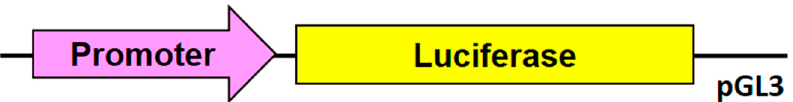
Figure 3. Scheme of the reporter constructs (based on pGL3). Promoter—FAP, CXCL12, IGFBP2, CTGF, JAG1, SNAI1, or SPARC, which are the promoters of the respective genes. Luciferase: firefly luciferase gene.